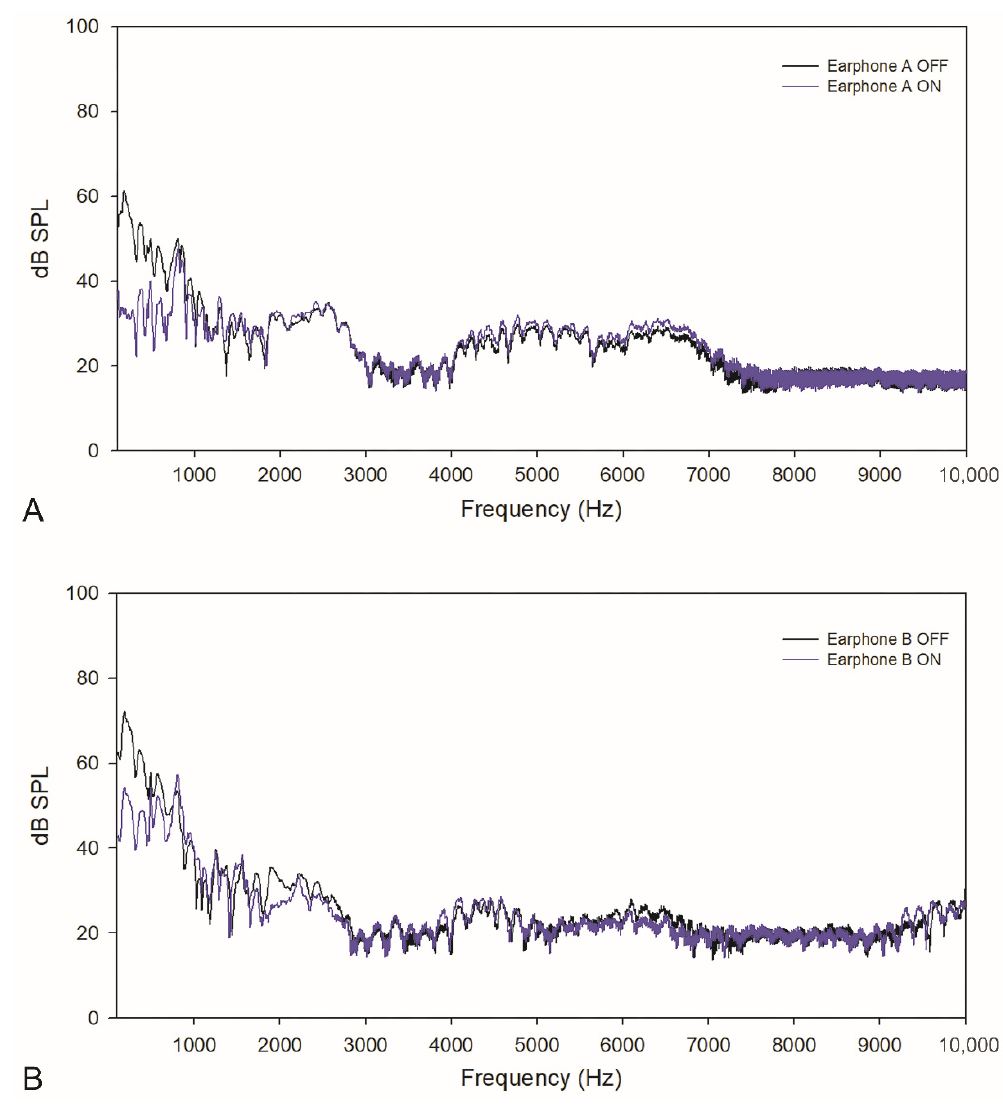
Figure 1. Acoustic characteristics of bus noise in earphone ( A ) and ( B ).